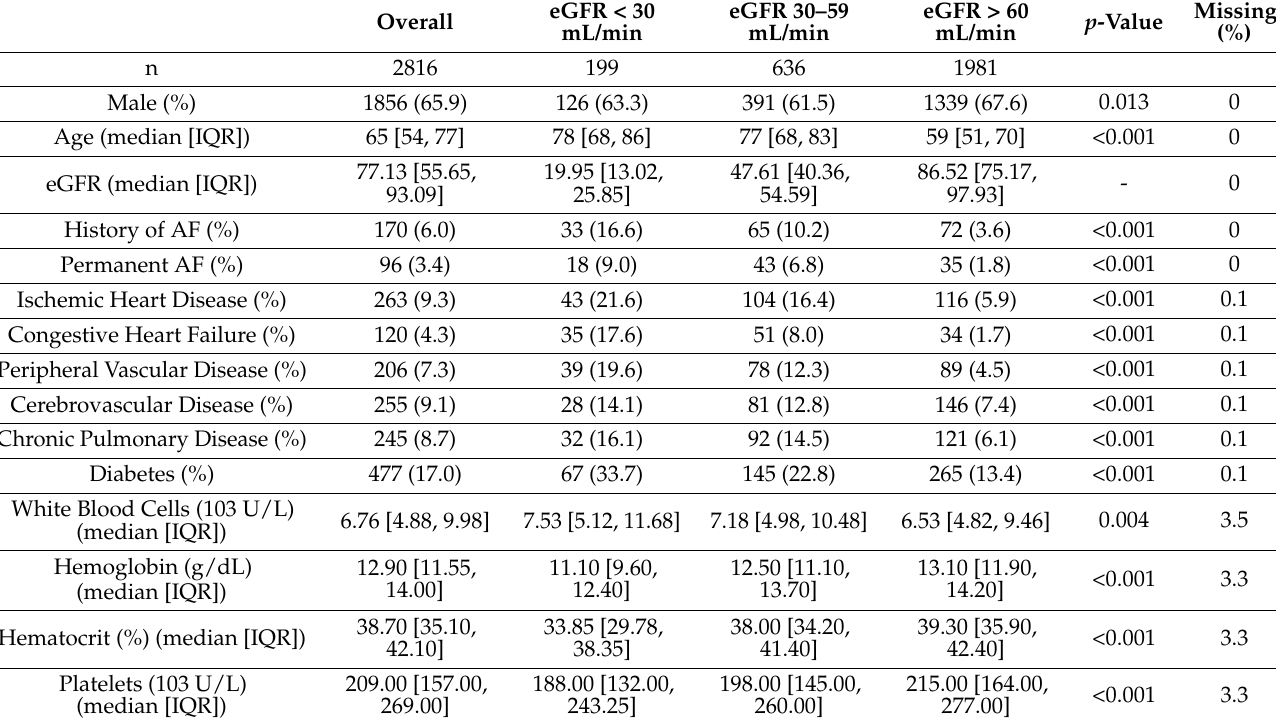
Table 1. Baseline characteristics (overall and by renal